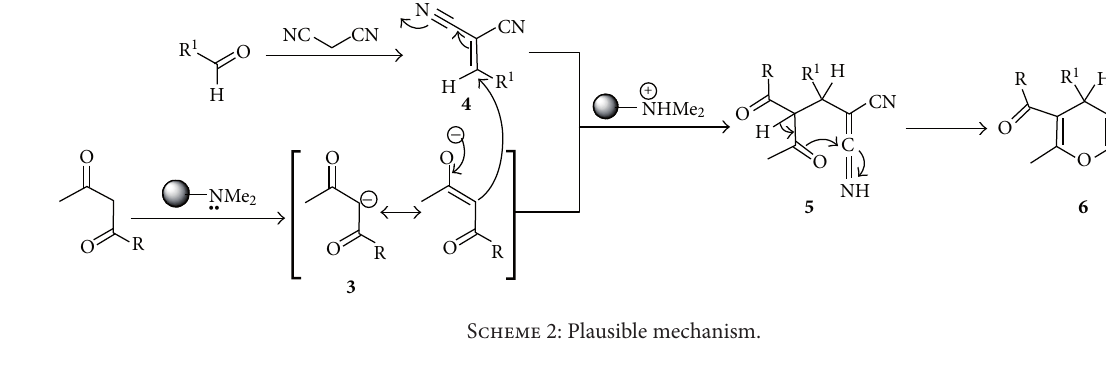
S 2: Plausible mechanism.